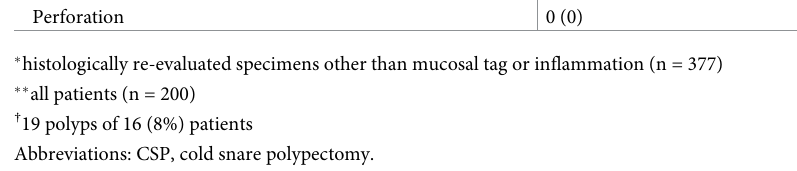
Table 3. Efficacy and safety of CSP. Outcome